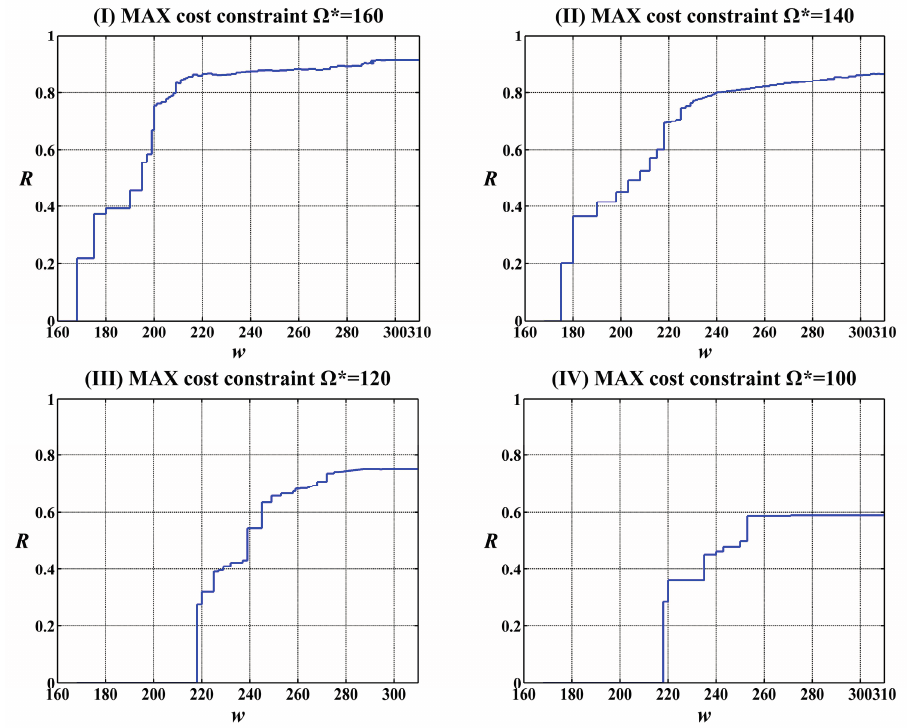
Figure 6. Change of the values of reliability function R ( w * ) along with the execution time w under the given expected execution time w * = 250.